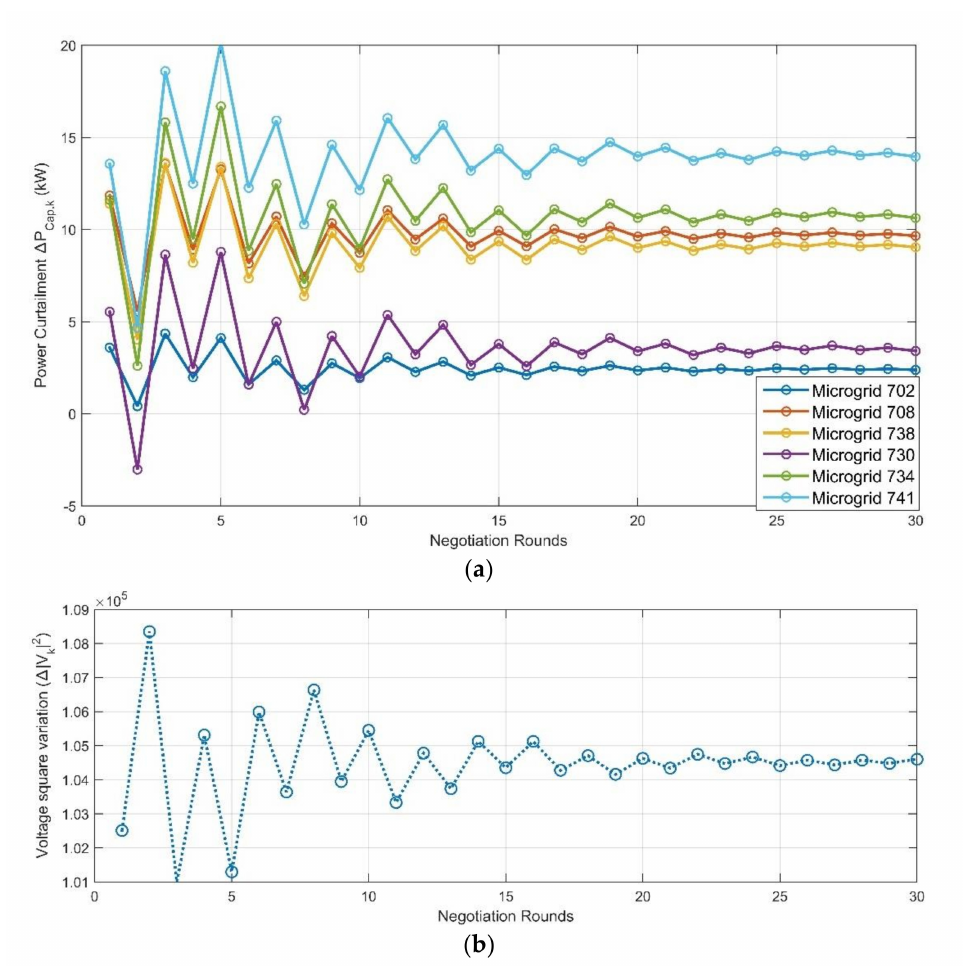
Figure 8. Updates of microgrid power curtailment ∆ P Cap,k and the voltage square variation ∆ | V 741 | 2 during negotiation. ( a ) shows the power capacity curtailment evolvements of di ff erent VGI Microgrids along the distribution line during the negotiation process. ( b ) shows the voltage square di ff erence caused by change of VGI Microgrids power capacity change during the negotiation